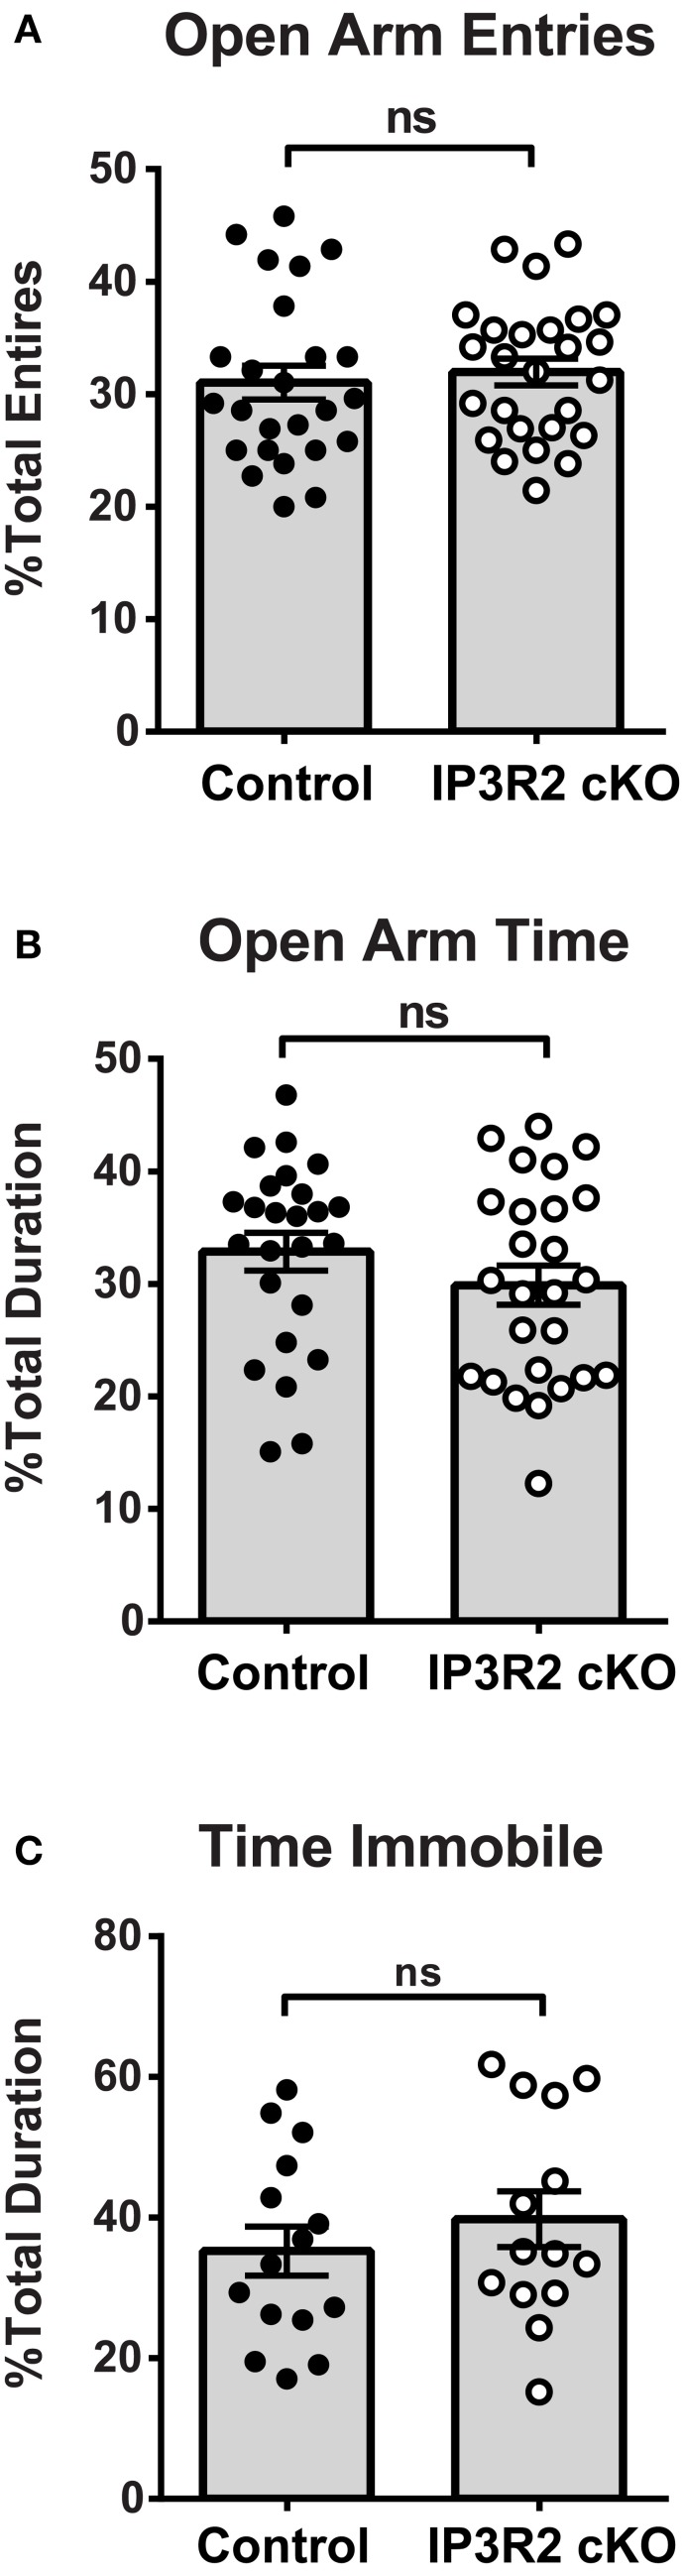
Anxiety and depressive behaviors are not affected in the IP3R2 cKO. (A,B) Anxiety-like behavior in the elevated plus maze is unaffected in IP3R2 cKO mice. IP3R2 cKO (n = 26, clear circles) and littermate control (n = 25, black circles) mice are not significantly different for open arm entries (p = 0.62) or percent duration spent in open arms (p = 0.22) in the elevated plus maze. (C) Depressive-like behaviors measured by tail suspension are unaffected in IP3R2 cKO mice. No significant difference (p = 0.39) was observed between the IP3R2 cKO (n = 14, clear circles) and controls (n = 15, black circles) in the suspended tail hang test. Error bars indicate s.e.m.